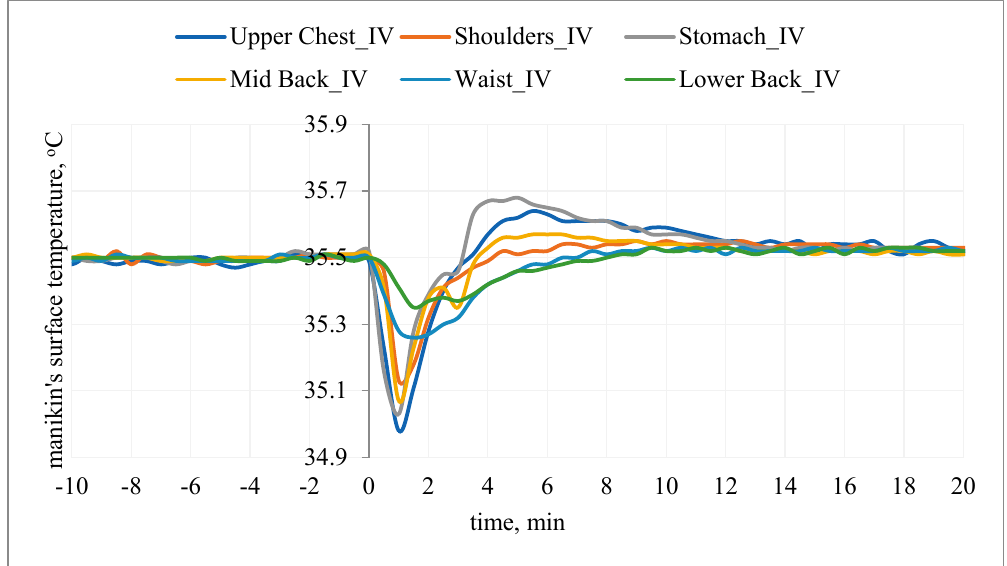
Figure 15. The temperature of the manikin’s surface after application of T-shirt with PCM under the outer clothing (variant IV). After application of T-shirt A without PCM under the outer clothing, at the begin- ning, the temperature of the manikin’s surface decreased from the assumed value of 35.5 °C by approx. 0.5 °C (chest, stomach segments) and approx. 0.3 °C (other segments), and then increased from the assumed value of 35.5 °C by approx. 0.1 °C (waist segment, lower back, shoulders) and 0.25–0.33 °C (stomach, upper chest, mid-back segments). The differ- ences in values may result from the T-shirt fitting the manikin’s shell (Figure 14). After application of T-shirt A with PCM under the outer clothing, a decrease in the temperature of the manikin’s surface from the assumed value of 35.5 °C by approx. 0.5 °C (upper chest, shoulders, stomach, mid-back segments) and approx. 0.2 °C (waist, lower back segments) was observed at the beginning, followed by an increase from the assumed value of 35.5 °C by max. 0.17 °C (stomach segment). The use of PCM resulted in a smoother course of temperature changes on the surface of the manikin (Figure 15). Based on the above dependence, it can be said that in the period of 20 min after ap- plication of the T-shirt with PCM under the outer clothing, the value of heat flux density increased in relation to the T-shirt without PCM. Thus, we observed the desired heat reception from the thermal manikin through the cooling elements (Figure 16).